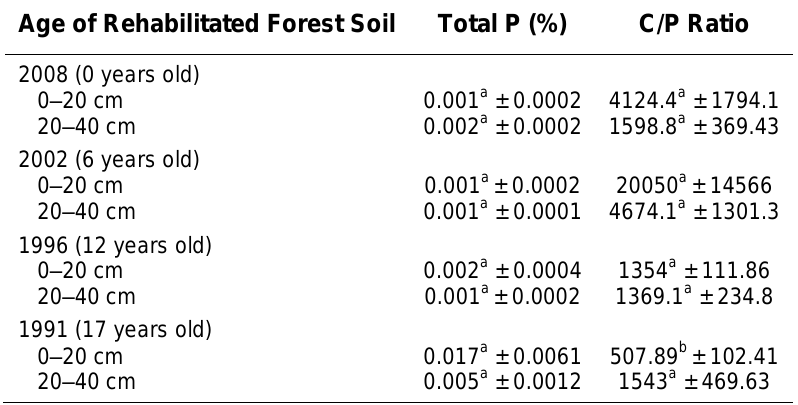
Total P and C/P Ratios of a Rehabilitated Forest Soil (between Depths) Age of Rehabilitated Forest Soil